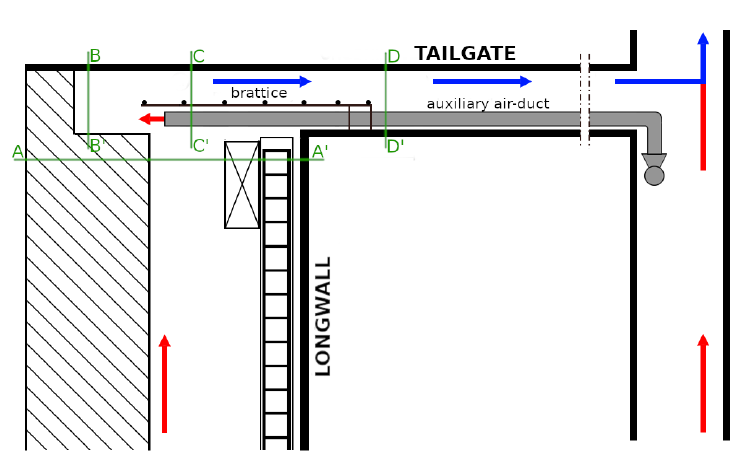
Figure 6. Result planes in the modeled excavation.